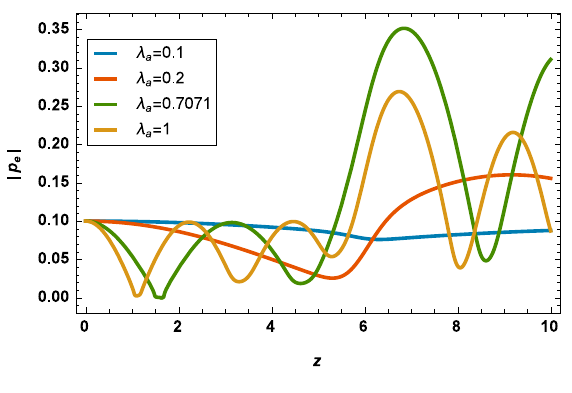
Fig. 3 Pressure along Locally Constricted Tube for Various Values of λ a with α = 20 , β = 0 . 5